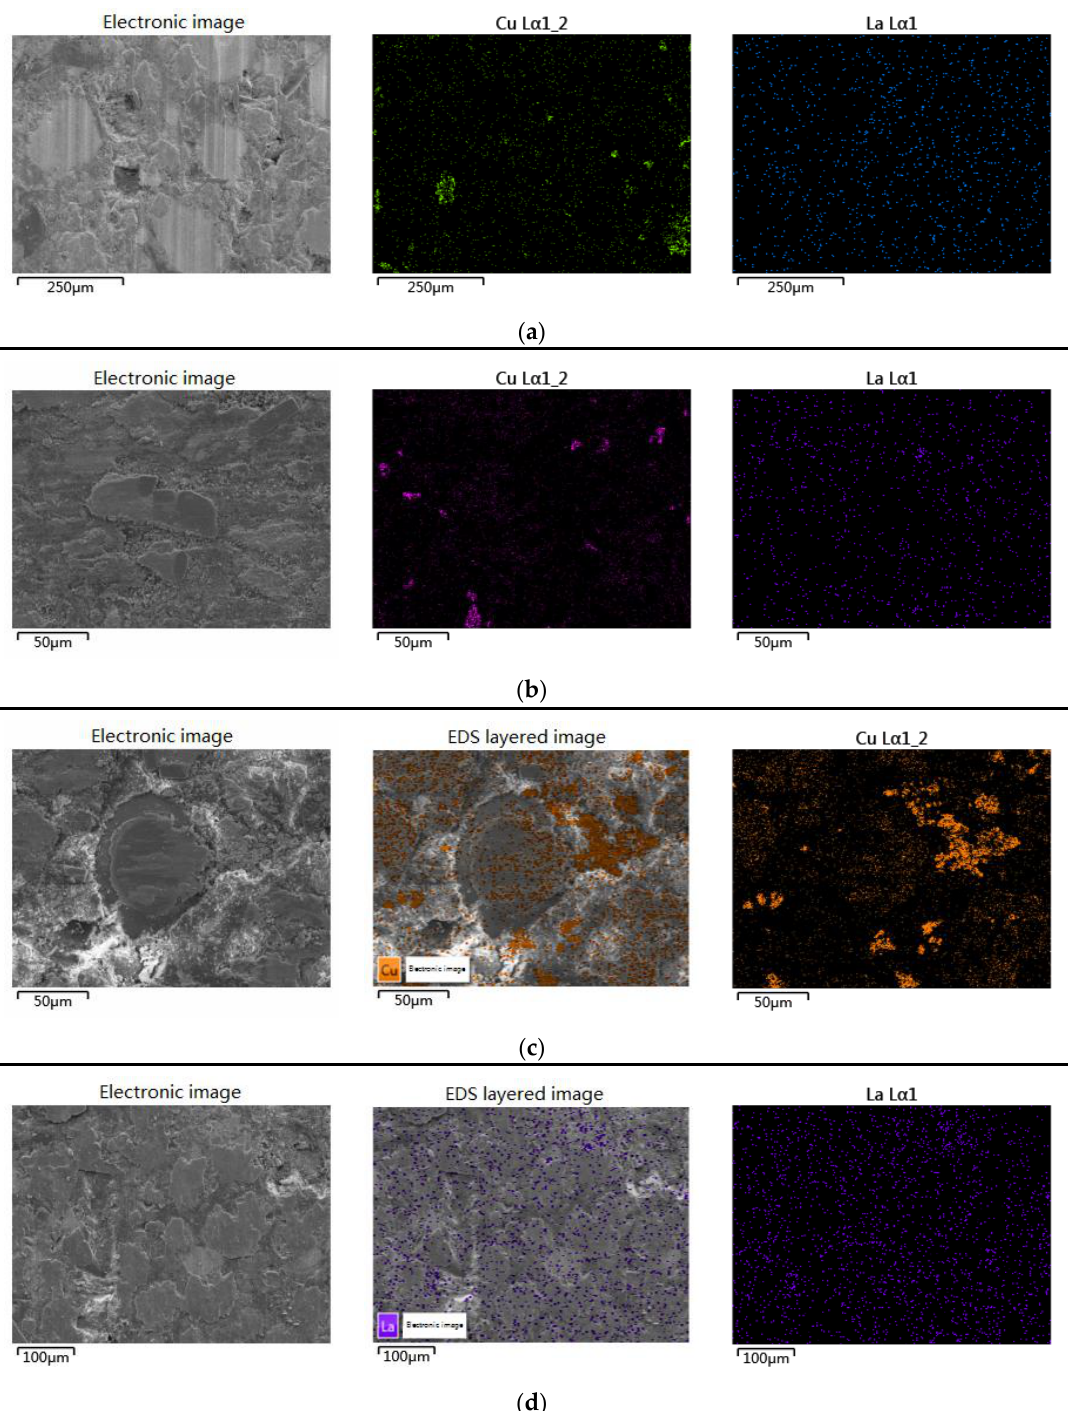
Figure 7. Worn surfaces of composites-EDS elemental mapping images: ( a ) C 10 L 5 ; ( b ) C 5 L 10 ; ( c ) C 15 L 0 ; ( d ) C 0 L 15 .